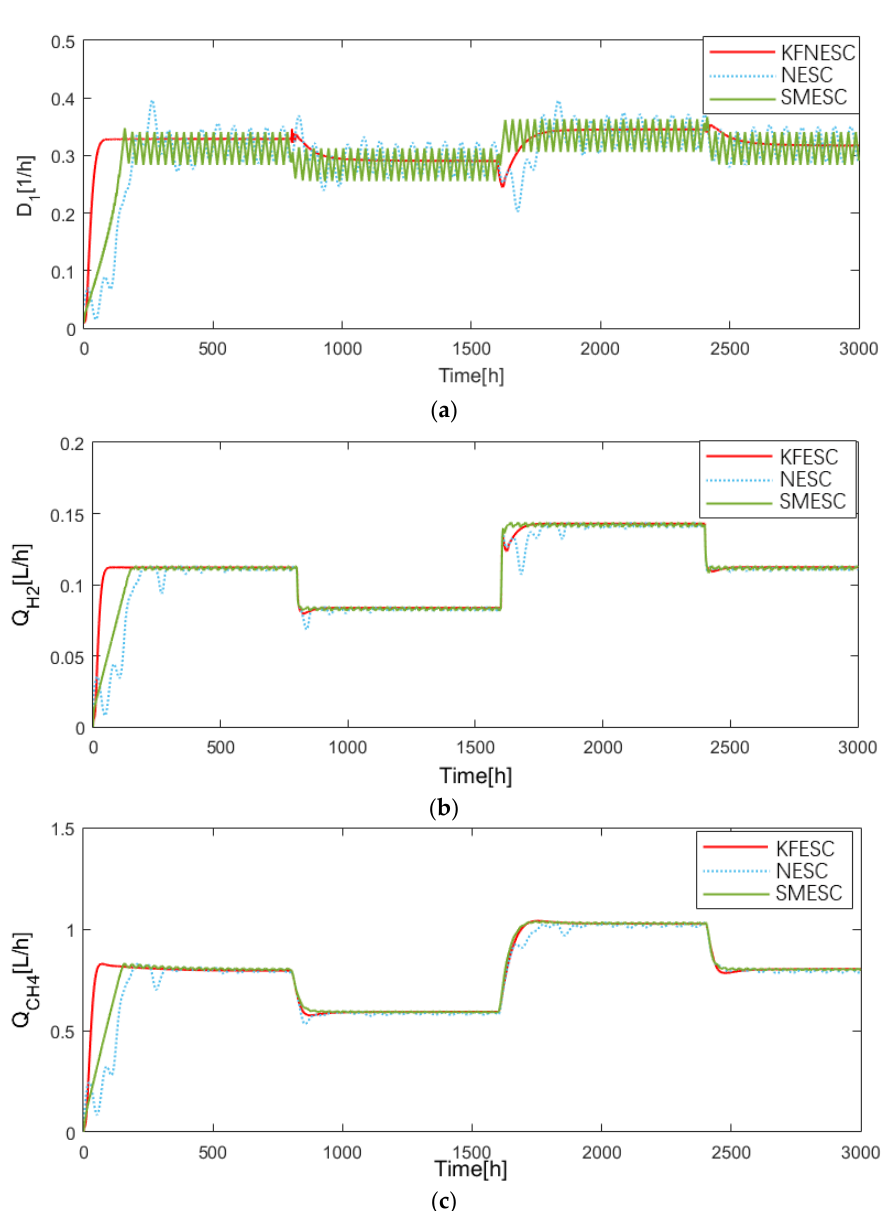
Figure 6. AD processes for different ESC and hydrogen production rate as optimization target. ( a ) Input: dilution rate, ( b ) Optimization target: hydrogen production rate, ( c ) Methane production rate. It can be seen that when the inlet organics concentration S in 1600 h and 2400 h, the proposed KFNESC ensures the shortest convergence time and smoothness of the dilution rate and gas production rate evolution. KFNESC also ensures dilution rate and gas production rate without chattering during steady state changes and hydrogen production rate as optimization target are shown in Figure 7.